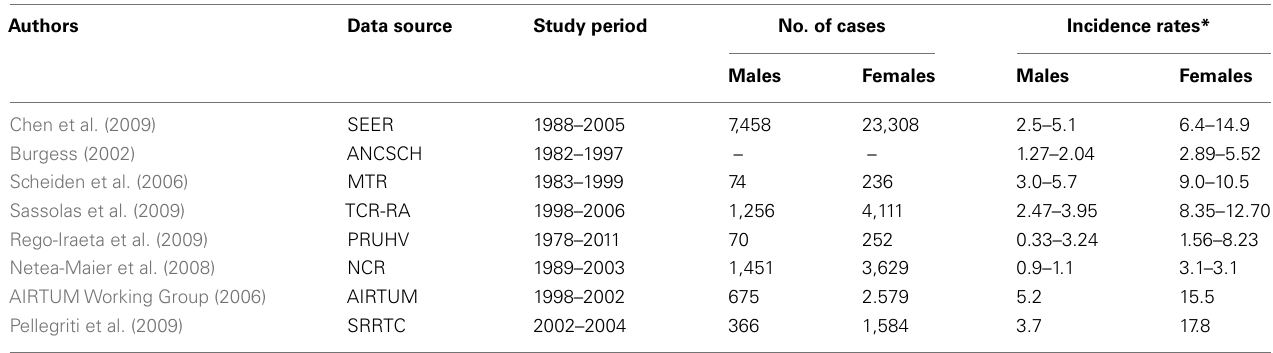
Table 1 |Age-adjusted thyroid cancer incidence rates from different population-based cancer